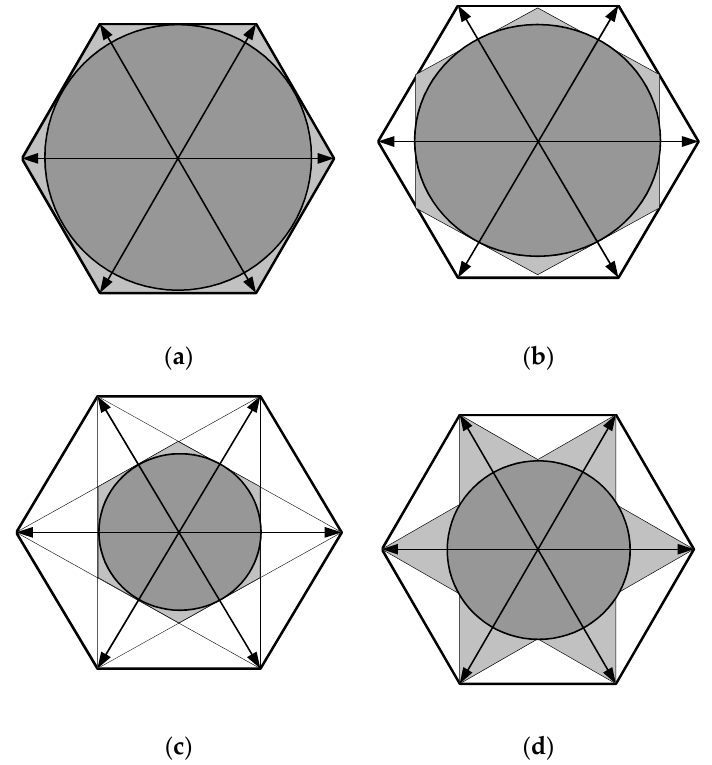
Figure 1. PWM switching algorithms: ( a ) SVPWM, DPWM, AZSPWM; ( b ) SPWM; ( c ) RSPWM; ( d ) RCMV-PWM.